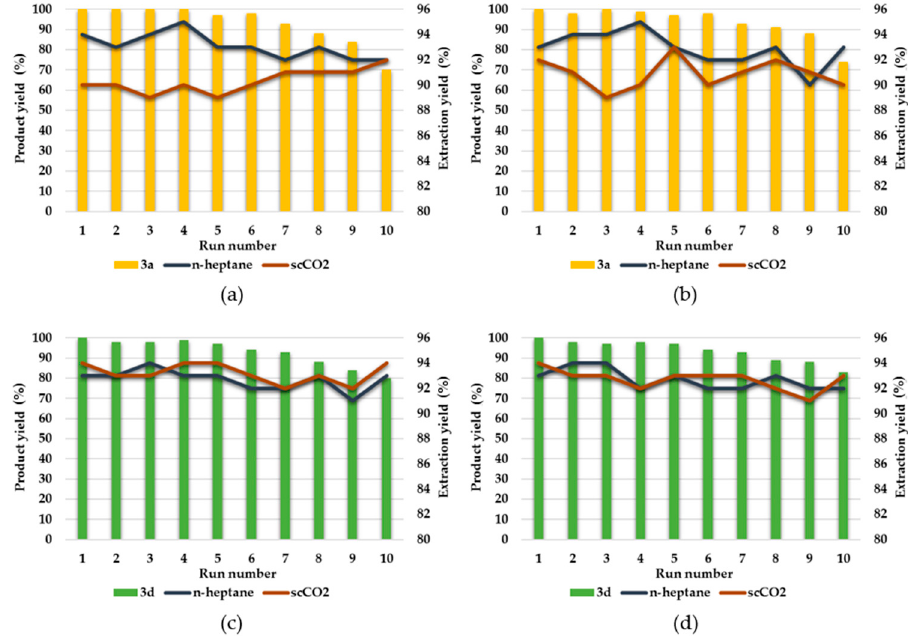
Figure 2. Repetitive batch borylative coupling of 1 with 2a in [BMIm][OTf] ( a ) and [EMPyr][NTf 2 ] ( b ) or 1 with 2d in [BMIm][OTf] ( c ) and [EMPyr][NTf 2 ] ( d ) under optimized reaction ([Ru-H]: 1 : 2a or 2d = 0.01:1:1.5, 110 ◦ C, 6 h, 1 g of IL, inert atmosphere conditions) and extraction (3 × 5 mL of n